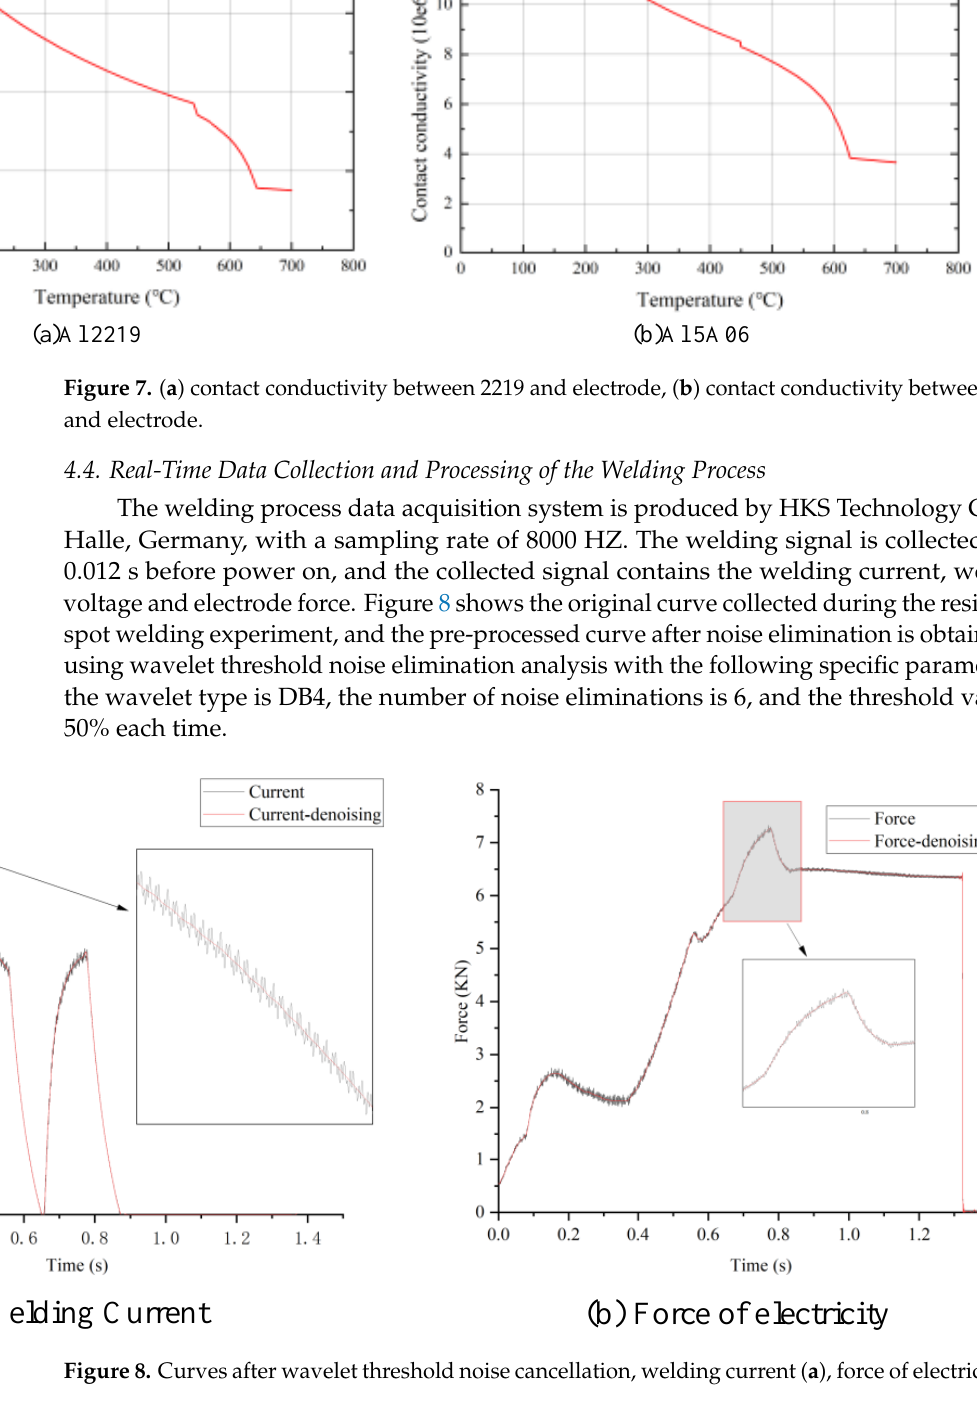
Figure 9. Digital twin model input data, ( a ) welding current, ( b ) force of electricity. 5. Results and Discussion The use of a digital twin model for 5A06/2219 spot welding process temperature field and current density changes with time simulation is presented in this paper. At the begin- ning of spot welding, the temperature field after 100 ms of welding current is shown in Figure 10a, and it can be seen from the figure that the temperature of the contact area between the spherical electrode and the aluminum plate is significantly higher than in other parts; at this time, the contact resistance is the dominant factor affecting the heat generation, and the heat is mainly generated at the interface. Setting the spot welding time to 150 ms (Figure 10b), the time spent in the preheating phase of the second heating pulse is greater compared with the time spent in the preheat- ing of the initial temperature field, when the heat production gradually increased from the contact resistance to the body resistance. Setting the spot welding time to 200 ms, for which the temperature field is shown in Figure 10c, the time entered the welding phase, the highest temperature of the workpiece reached 910 K, began to melt, and the overall source of heat at this time was the body resistance dominated by the resistance heat effect,